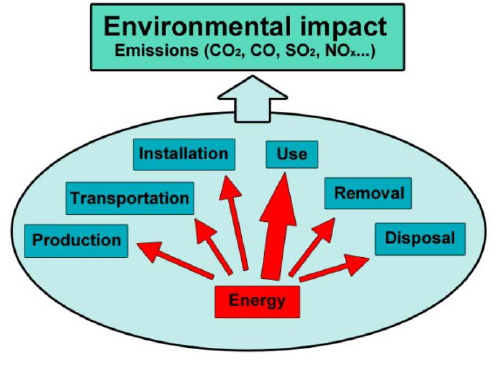
Figure 11. Environmental impact evaluated using a standard Life Cycle Assessment (LCA).